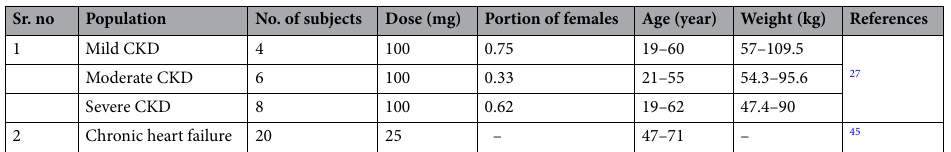
Table 3. Population data used for development and evaluation of the captopril PBPK model in disease populations. CKD chronic kidney disease.